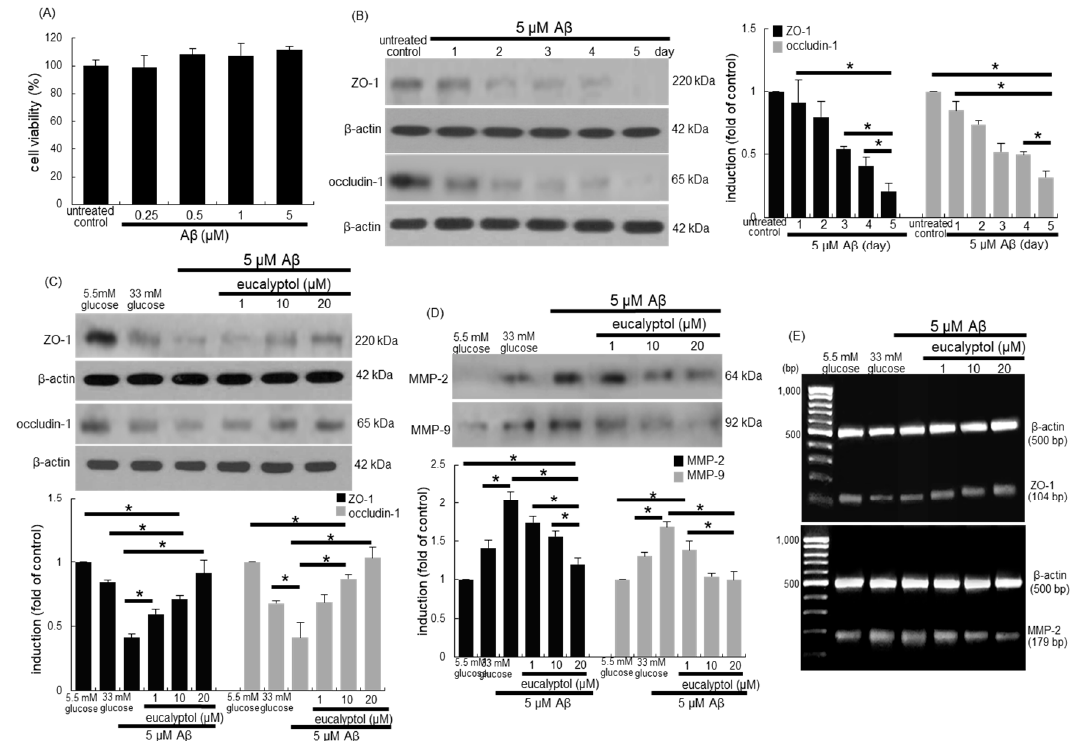
Figure 7. Dose-responses of A β to human retinal pigment epithelial (RPE) cell toxicity ( A ), temporal induction of tight junction markers of ZO-1 and occludin-1 by A β ( B ) and effects of eucalyptol on cellular induction of ZO-1 and occludin-1 and secretion of MMP-2 and MMP-9 ( C and D ). Cell viability was measured by using an MTT assay (A, 100% viability with untreated control). Bar graphs for viability (mean ± SEM, n = 5) was expressed as percent cell survival. RPE cell lysates were subject to western blot analysis using a primary antibody of ZO-1, occludin-1, MMP-2, MMP-9 and β -actin for an internal control ( B – D ). The bar graphs (mean ± SEM, n = 3) represent quantitative results of blot bands. * Values in respective bar graphs indicate a significant difference at p < 0.05. The mRNA transcriptional levels of ZO-1 and MMP-2 were measured using RT-PCR analysis. β -Actin was used as a housekeeping gene for the co-amplification with ZO-1 and MMP-2 ( E ).